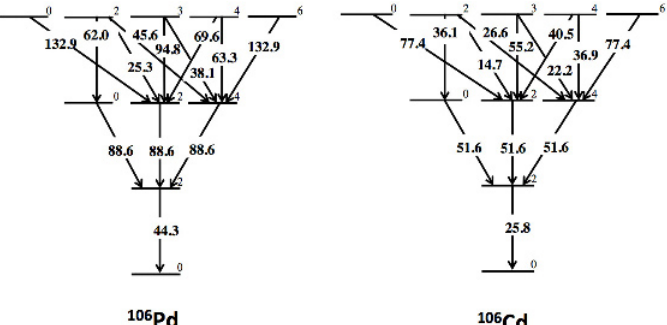
Figure 1. Low-lying levels and the reduced E 2 transition strengths in W.u. given by the harmonic spherical- vibrator model for 106 Pd and 106 Cd. The reduced transition rates are normalized to the experimental values of 44.3(15) and 25.8(3) W.u. for the one-phonon to ground-state transitions for 106 Pd [9] and 106 Cd [9], respectively.